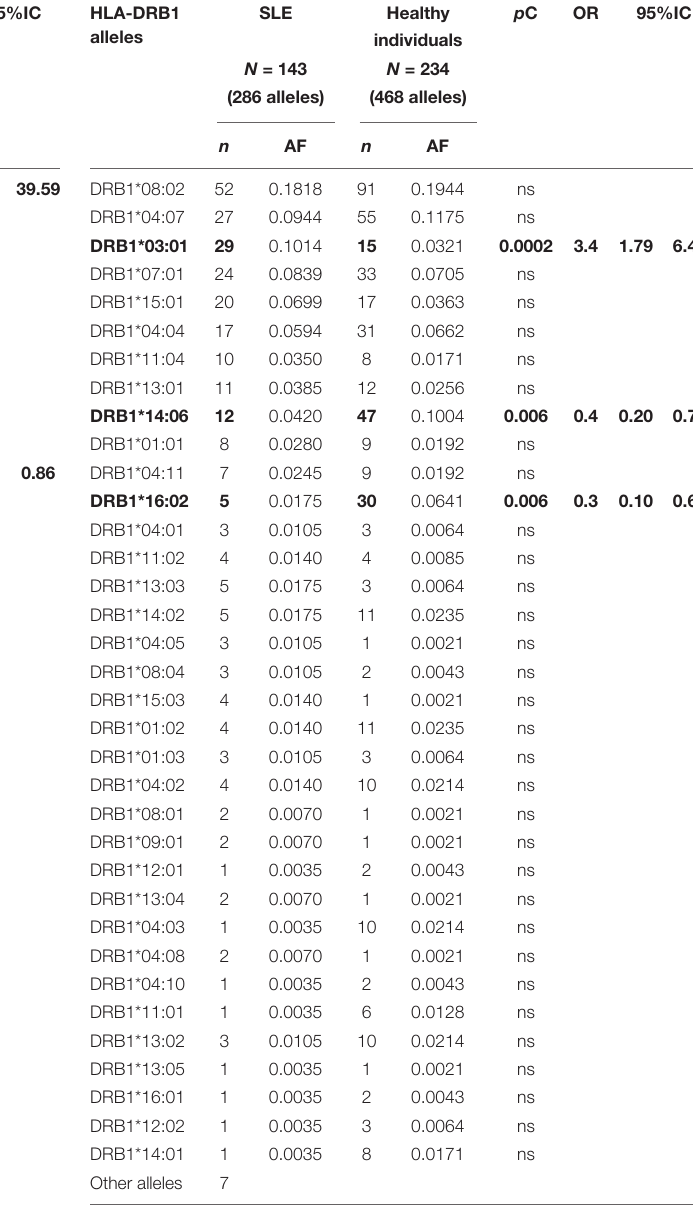
TABLE 3 | Human leukocyte antigen-B allele frequencies in SLE patients and healthy individuals.